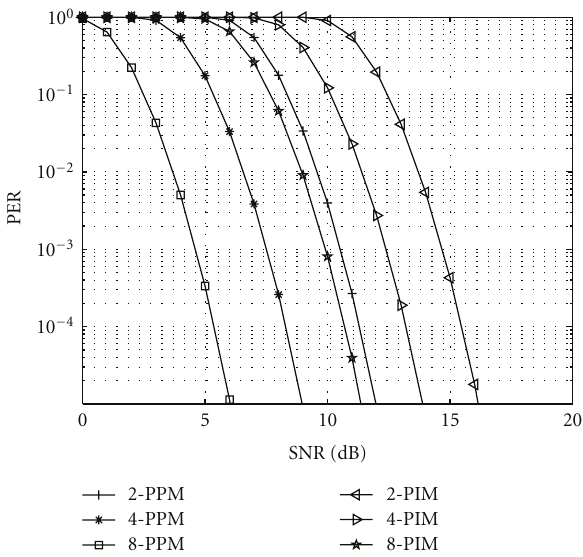
Figure 7: PER performance comparison of PPM and PIM for the same average power per